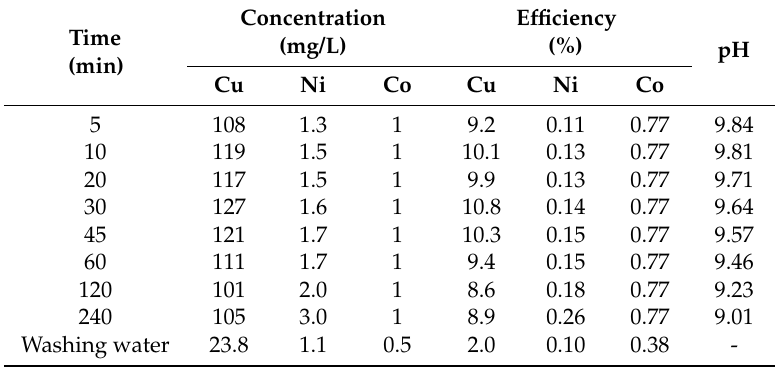
Table 5. Metals concentration and extraction efficiency of ammoniacal leaching with ultrasound at room temperature.